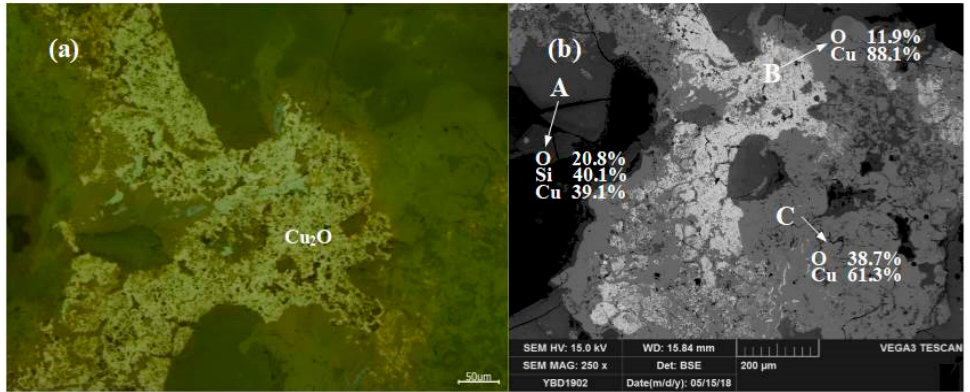
Figure 11. Optical micrograph ( a ) and SEM backscattered electron image ( b ) of YBD19.